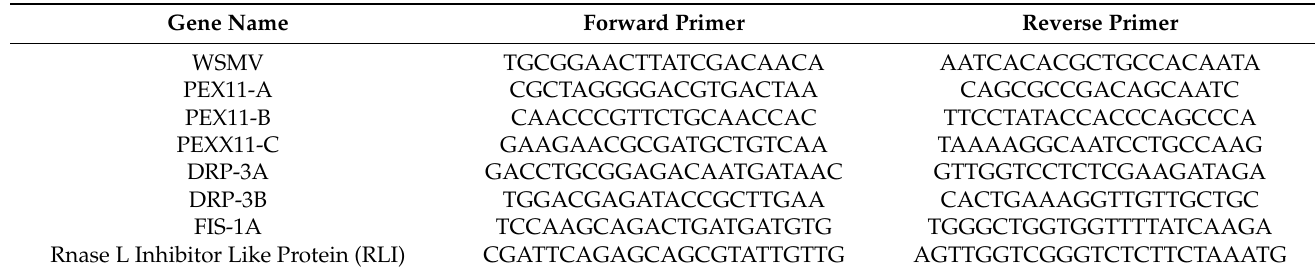
Table 1. Sequences of primers used in this